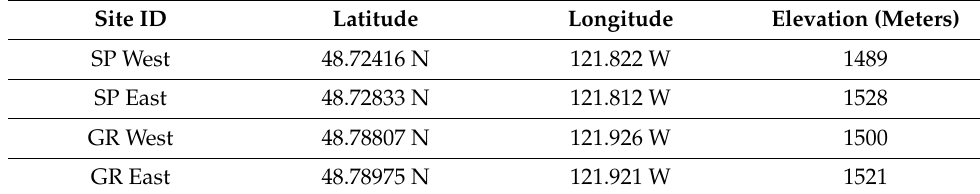
Table 1. Coordinates and elevation for each